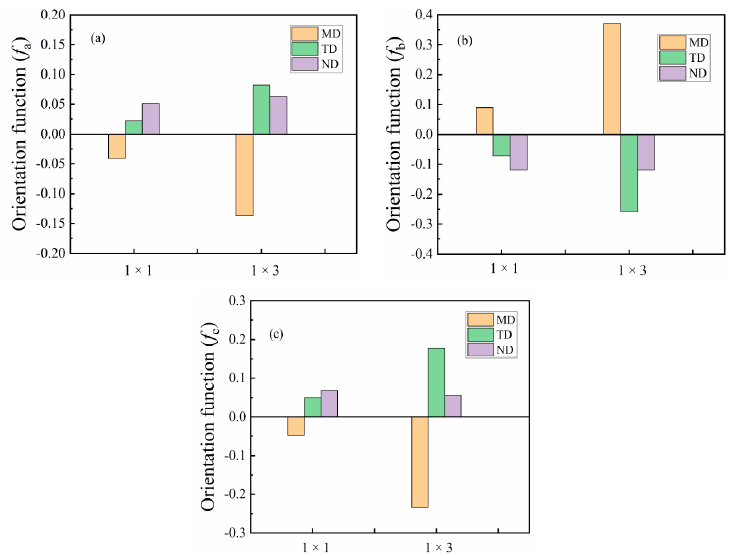
Figure 5. Orientation function of the γ crystal population of ( a ) a -axis, ( b ) b -axis and ( c ) c -axis for 1 × 1 and 1 × 3 stretched films at 1208 cm − 1 .